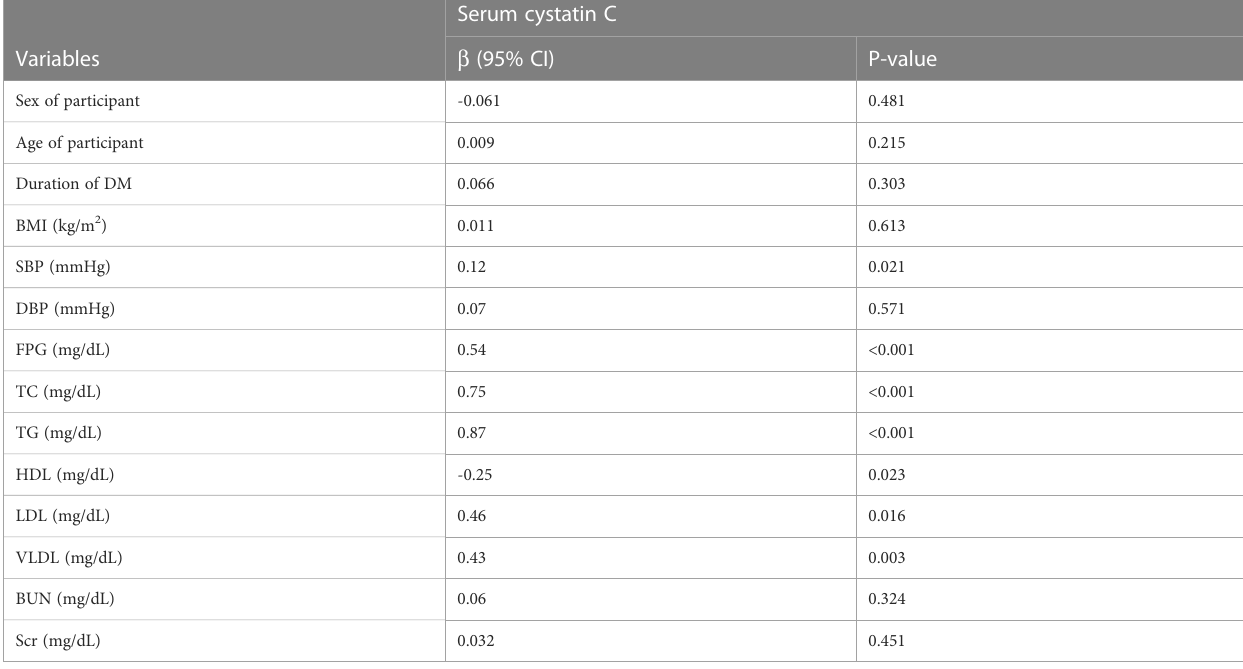
TABLE 4 Multiple linear regression analysis of serum cystatin C with clinical and biomedical parameters in type 2 diabetic patients.